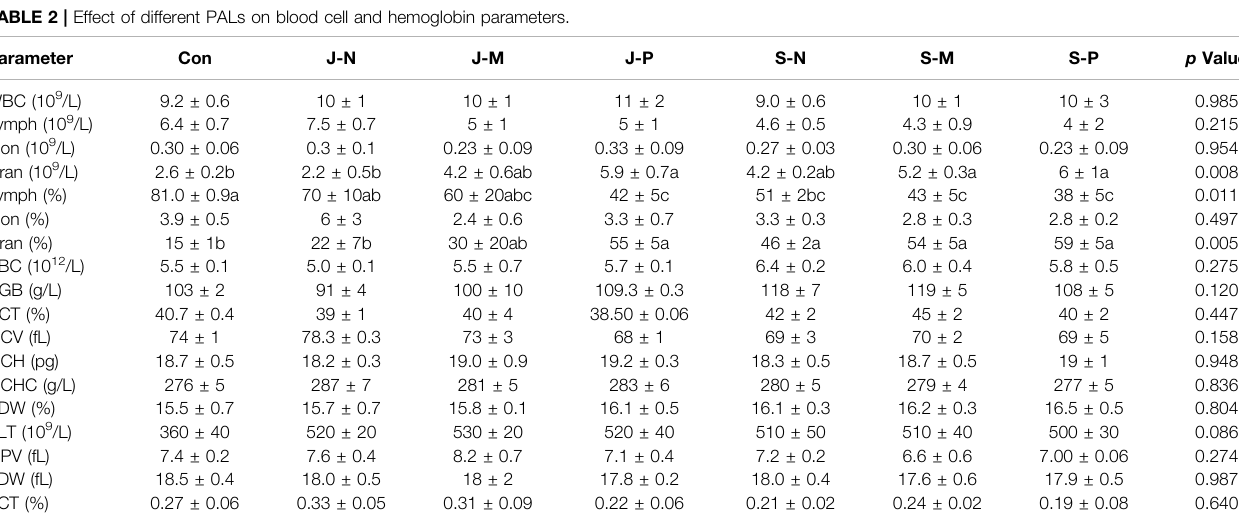
TABLE 2 | Effect of different PALs on blood cell and hemoglobin parameters.